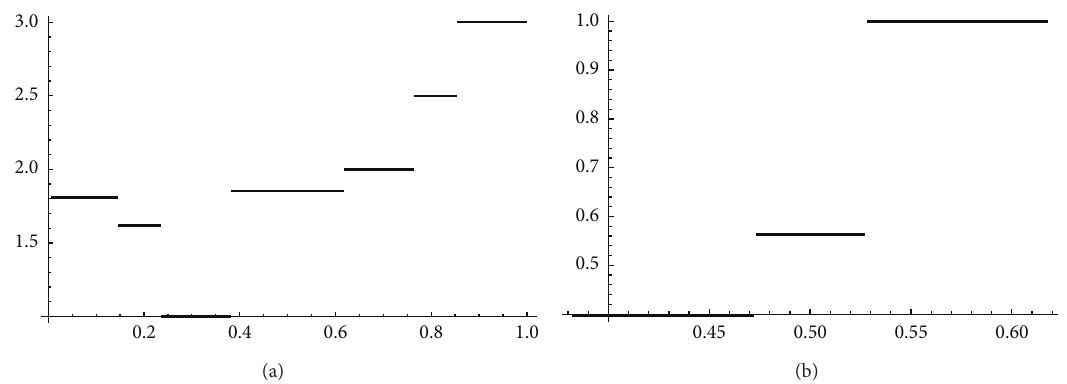
Figure 10: Example of density 𝑝(𝑥) from Proposition 9 ( 𝑝 1 = 1 , 𝑝 ∗ 1 = 2 , 𝑝 ∗ 3 = 3 , 𝑝 ∗ 2 = 2.5 ) (a) and corresponding function 𝛼 1 (𝑥) (on [𝑎,1−𝑎] ) (b).